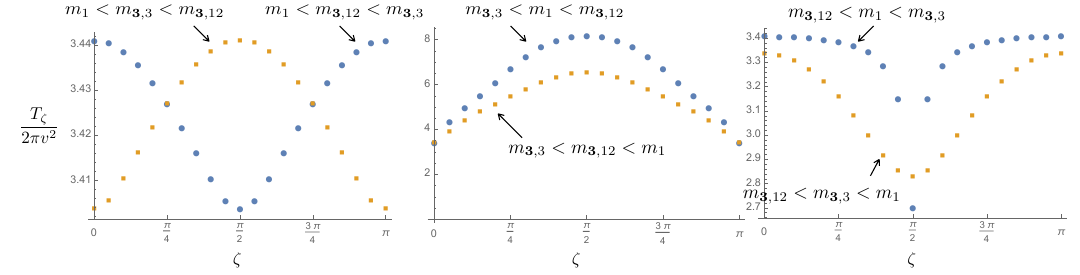
Figure 7 . The (cid:16) dependence of the string tension in the model with modi(cid:12)ed potential in eq. (5.1). The left panel shows the cases with m 1 being the smallest while the middle and right show the cases with m 3 ; 3 and m 3 ; 12 are the smallest, respectively. For the left panel we take m 1 = 125 ; m 3 ; 3 = m W 80 20 m 1 ; m 3 ; 12 = 10 m 1 for the circle dots, and m 1 = 125 ; m 3 ; 3 = 10 m 1 ; m 3 ; 12 = 20 m 1 for the square m W 80 dots. For the middle panel we take m 3 ; 3 = 125 ; m 1 = 10 m 3 ; 3 ; m 3 ; 12 = 20 m 3 ; 3 for the circle dots, m W 80 and m 3 ; 3 = 125 ; m 1 = 20 m 3 ; 3 ; m 3 ; 12 = 10 m 3 ; 3 for the square dots. For the right panel we take m W 80 m 1 = 125 ; m 3 ; 3 = 10 m 1 ; m 3 ; 12 = m 1 = 2 for the circle dots, and m 3 ; 3 = 125 ; m 1 = 10 m 3 ; 3 ; m 3 ; 12 m W 80 m W 80